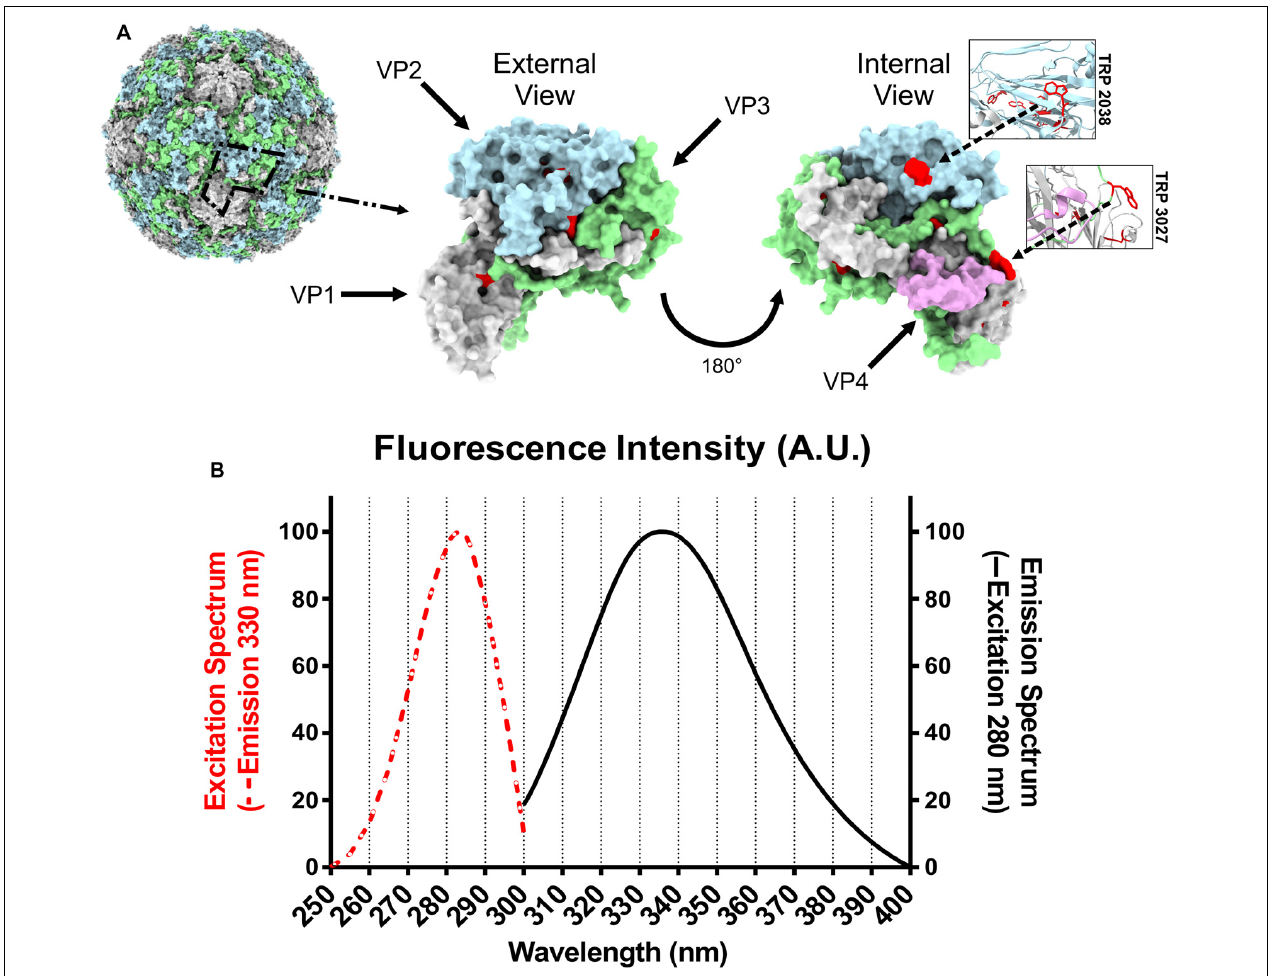
FIGURE 1 | Positions of RV-A2 tryptophan residues within a biological protomer and fluorescence spectra of RV-A2. (A) Left: 3D-structure surface-view (pdb:1FPN) with one protomer highlighted with a dashed black line. The solvent accessible surface is rendered by using a rolling sphere of 1.4 Å radius in Chimera. Middle and right: Surface of an isolated protomer viewed from within and from without the capsid. VP1, VP2, VP3, and VP4 are colored gray, blue, green, and rose, respectively. Tryptophan residues are depicted in red; the locations of TRP2038 and TRP3027 are additionally highlighted in the boxed ribbon diagrams representing the respective local tertiary structure. (B) Fluorescence spectra of RV-A2 in PBS. Normalized excitation (250–300 nm) and emission (300 – 400 nm) spectra were recorded in 1 nm steps. The measurement was repeated eight times, and the mean is shown. A.U., arbitrary